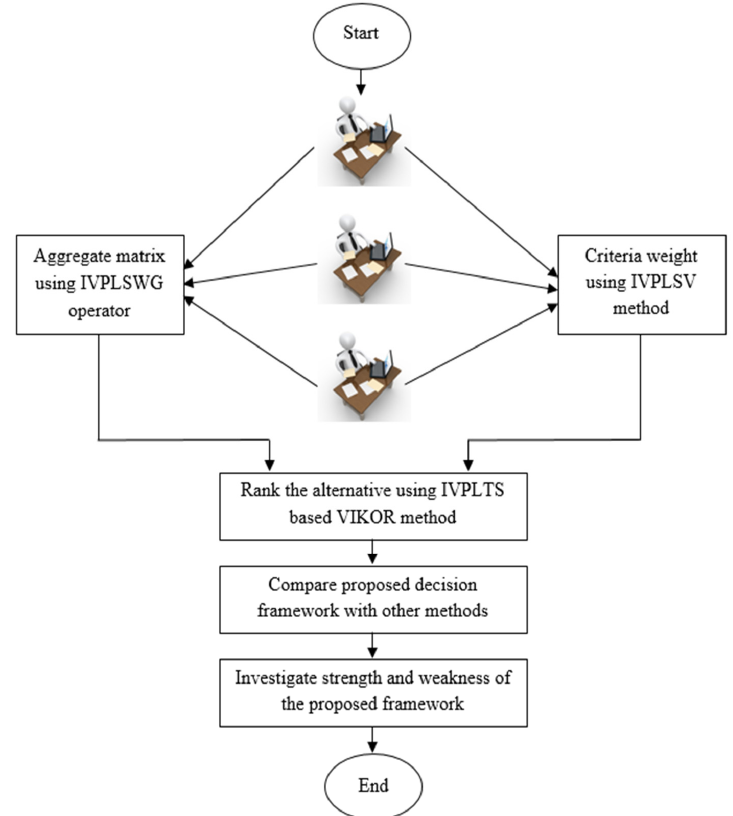
Figure 1. Structural design of developed decision framework under interval-valued probabilistic linguistic term set (IVPLTS) .